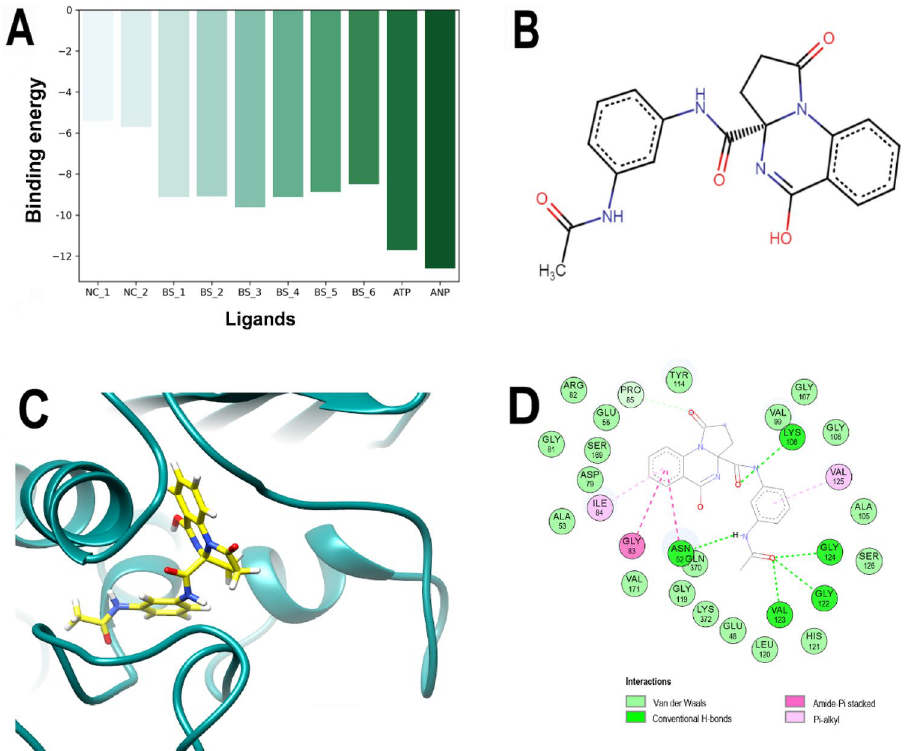
Figure 1. Best scored ligands, chemical structure, and analysis of the best-predicted docking pose of PQd calculated by LeDock. ( A ) Comparison of the binding energies among best scored natural products BS-1 (ZINC000040309506), BS-2 (ZINC000001529323), BS-3 (ZINC000012462127), BS-4 (ZINC000008577218), BS-5 (ZINC000064799791) and, BS-6 (ZINC000065074826), as well as ANP (ZINC000008660410), ATP (ZINC000011524400), and two negative controls NC-1(ZINC000001688375, 2-chloro-5-nitroaniline) and NC-2 (ZINC000003861263, 4-amino-1H-imidazole-5-carboxamide) calculated by LeDock. The ZINC code was omitted from the figure legend only for simplification. ( B ) Chemical structure of PQd. ( C ) 3D representation of the 3ZKBL-PQd complex. ( D ) 2D interaction diagram of the 3ZKBL-PQd